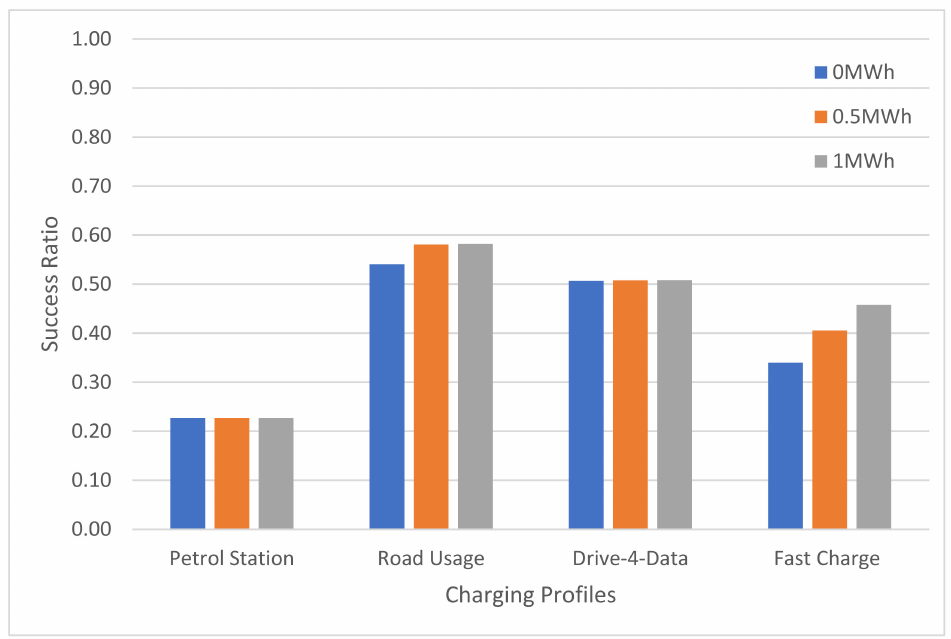
Figure 11. The success ratio of the grid-connected systems with incrementing